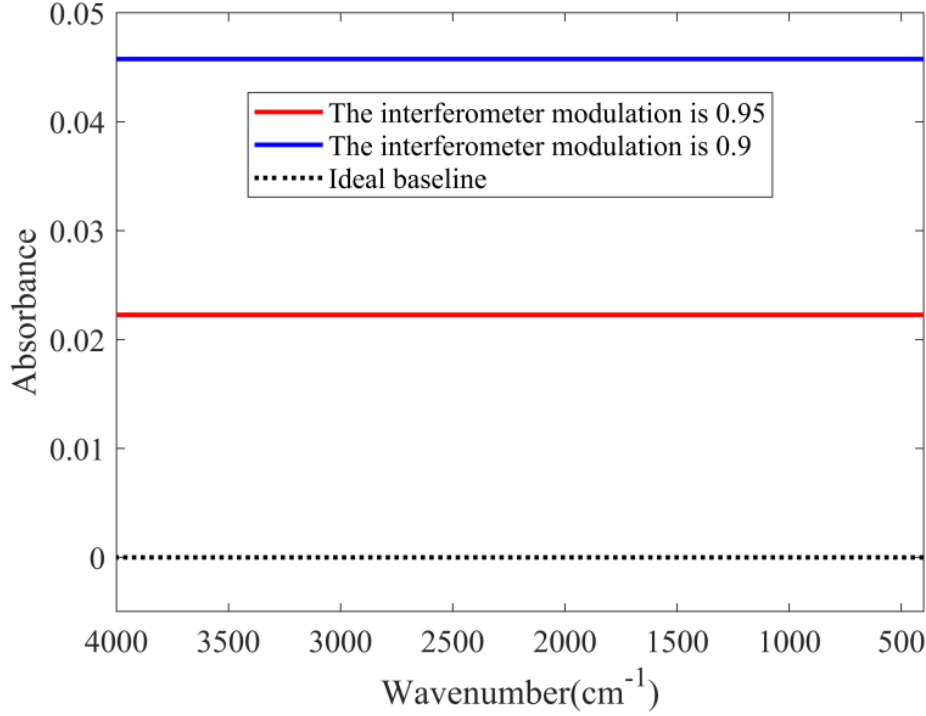
Figure 6. Baselines were obtained when the interferometer modulation is reduced to 0.95 and 0.9. Figure 6 indicates that if the interferometer modulation decreases during the entire scanning process, the baseline will shift upward, and the shift amplitude depends on the modulation degree. The simulated baselines for the temporary modulation changes are shown in Figure 7.